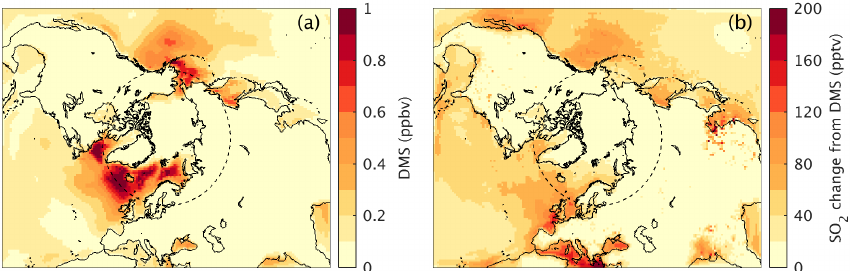
Figure 2. June–July average (a) DMS surface mixing ratios and (b) SO 2 surface mixing ratios due to the implementation of DMS emissions and gas-phase chemistry in the model (ALL_UPDATES – NO_DMS).